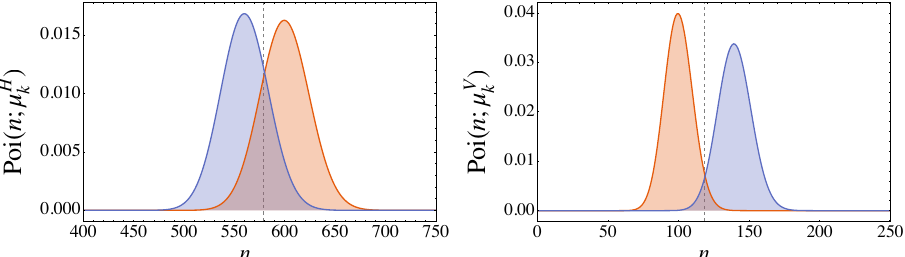
Figure 3. Probability density function of the Poissonian distribution in Equation (17) for the H detec- = 500, N dc = 100 and m = 11. The probability N c tor ( left plot ) and the V detector ( right plot ) for (cid:104) (cid:105) of error in Equations (25) and (29) are, respectively, p V e = 0.034 ( V detector) and p H e = 0.205 ( H detector). The gray dashed line is the threshold values in Equation (19). The values of the involved parameters have been chosen to better highlight the investigated